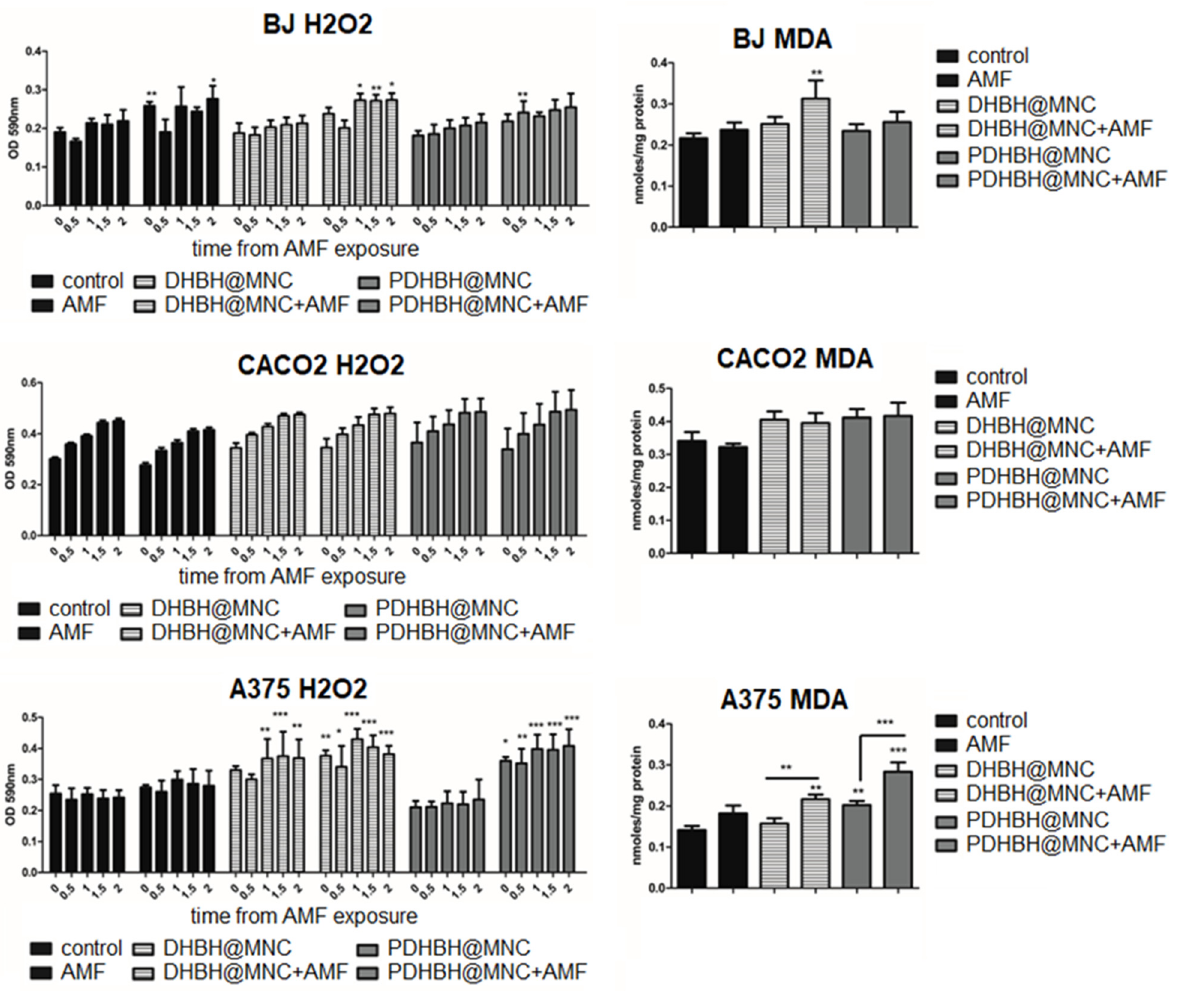
Figure 11. Oxidative stress of cells (fibroblasts (BJ), upper panels; colon adenocarcinoma (CACO2), middle panel; and melanoma (A375), lower panel) determined by Amplex Red measurement of the H2O2 level, immediately after MH treatment (readings were taken at 0, 0.5, 1, 1.5 and 2 h). Results are expressed as OD at 590nm (left panels) for each cell line; malondialdehyde (MDA) level at 24 h after MH treatment was measured through spectrophotometry, results are expressed as nmoles/mg protein (right panels). Each bar represents mean ± standard deviation (n = 3); * = p < 0.05, ** = p < 0.001, *** = p < 0.0001, control versus treated group (cells exposed to AMF, incubated with MNC with and without MH exposure) for each cell line.